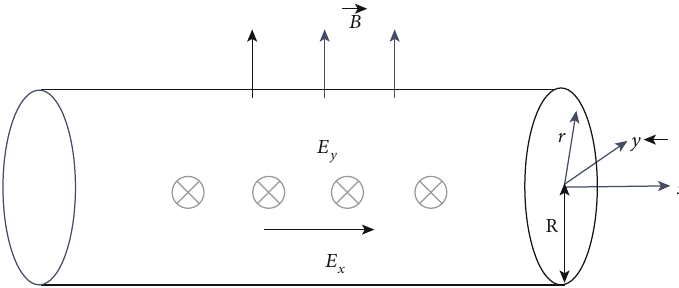
Figure 1: Sketch for EOF of Je ff rey fl uid in a circular microchannel under vertical magnetic fi